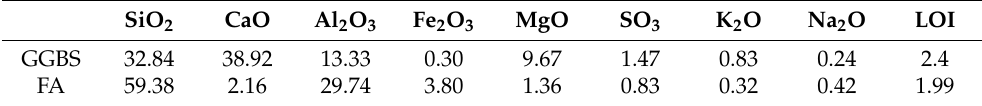
Table 1. Chemical compositions of GGBS and FA